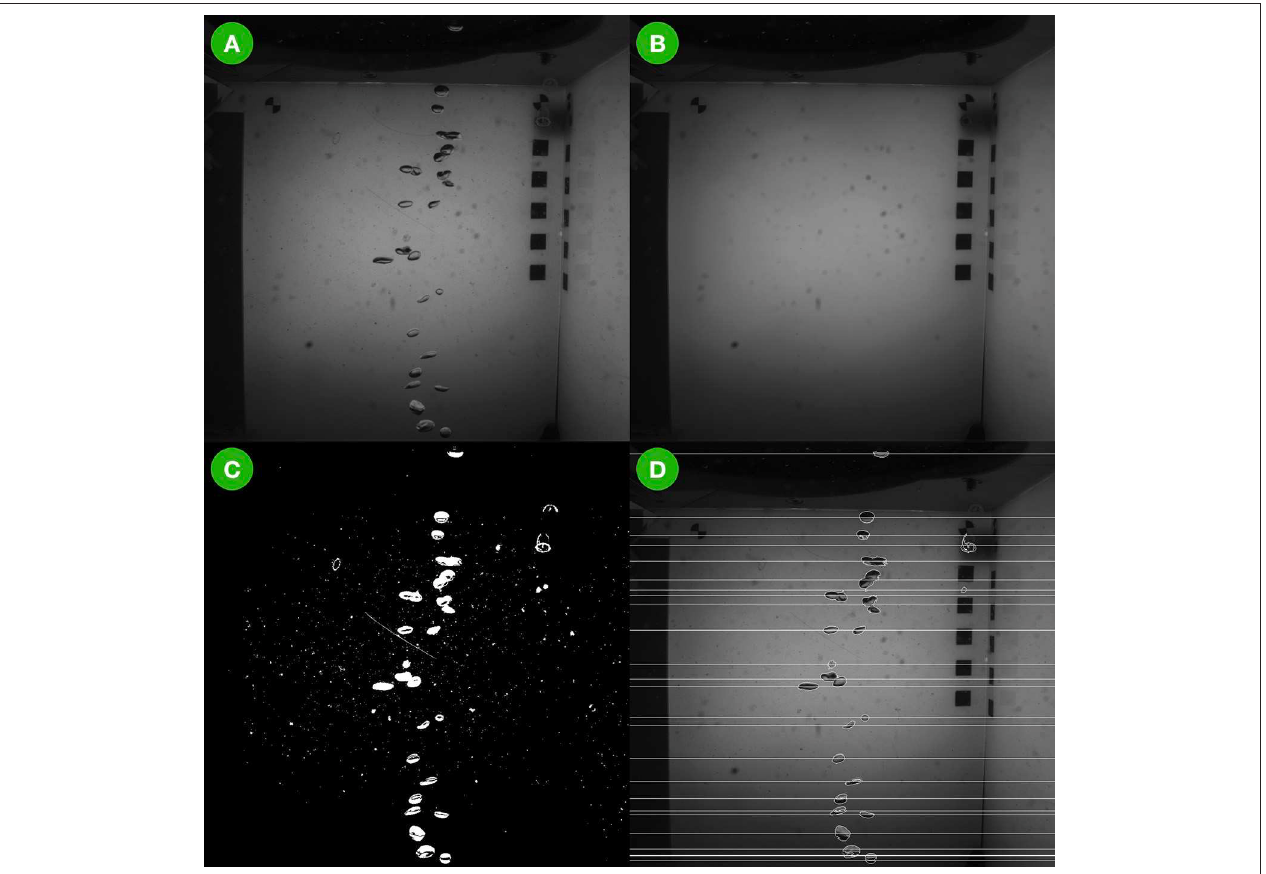
FIGURE 3 | The bubble image processing pipeline executed on the SHiPCC during cruise POS526 as a demonstration of operability. In (A) an original image is shown as acquired by the BubbleBox. In (B) the median-filtered version is shown where only the background remains and the foreground (i.e., the bubbles) has been removed. (C) Shows the binarized subtraction of (B) from (A) . Vertical bubble locations and outlines are marked in (D) .